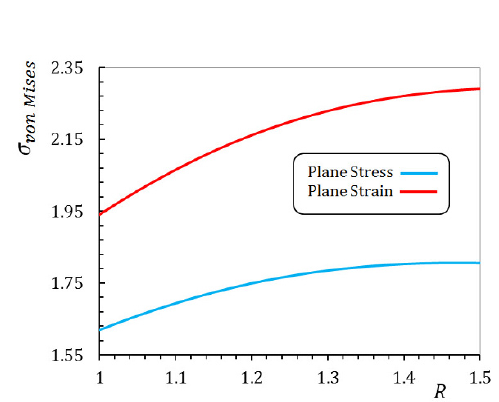
Figure 9. von Mises equivalent stress in the plane stress and plane strain conditions ( ξ = 3 , η = − 1 . 5) .